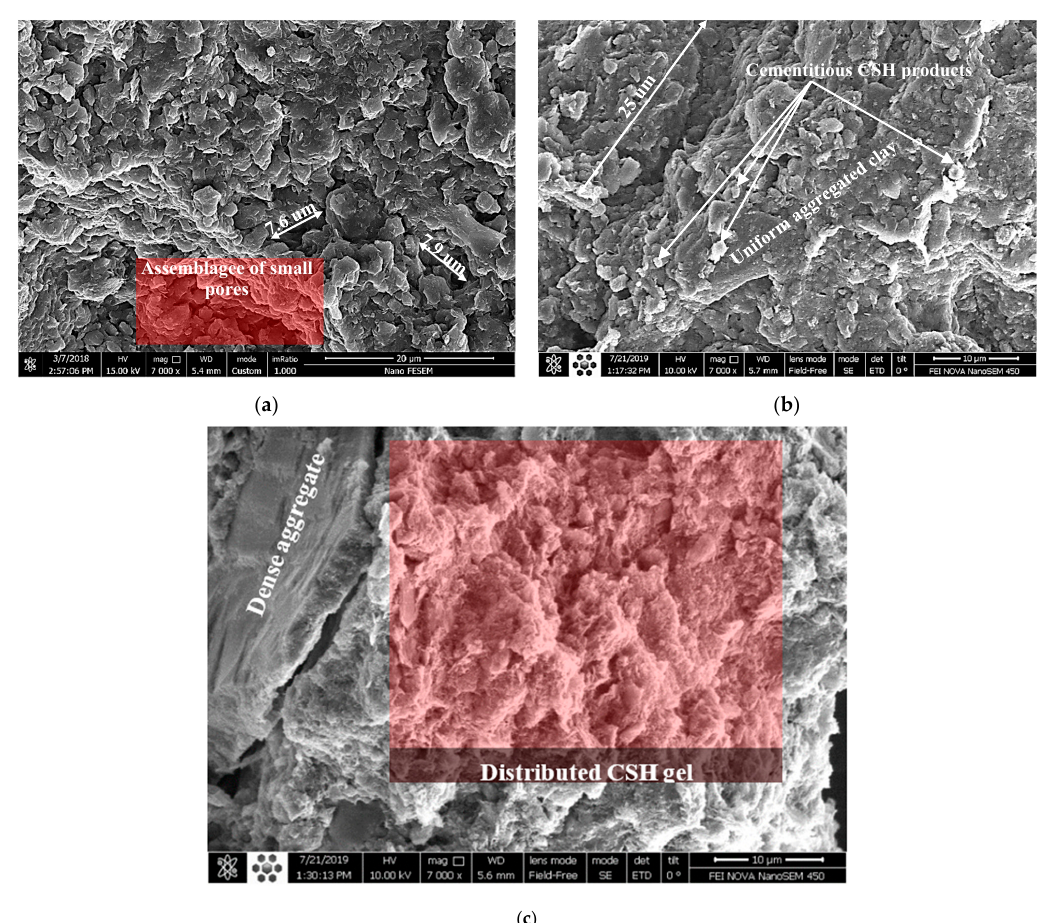
Figure 7. Scanning electron micrographs of treated marl cured for 28 days: ( a ) untreated marl; ( b ) 3% cemented marl; ( c ) 3% cemented and 1% nano-silica treated marl.